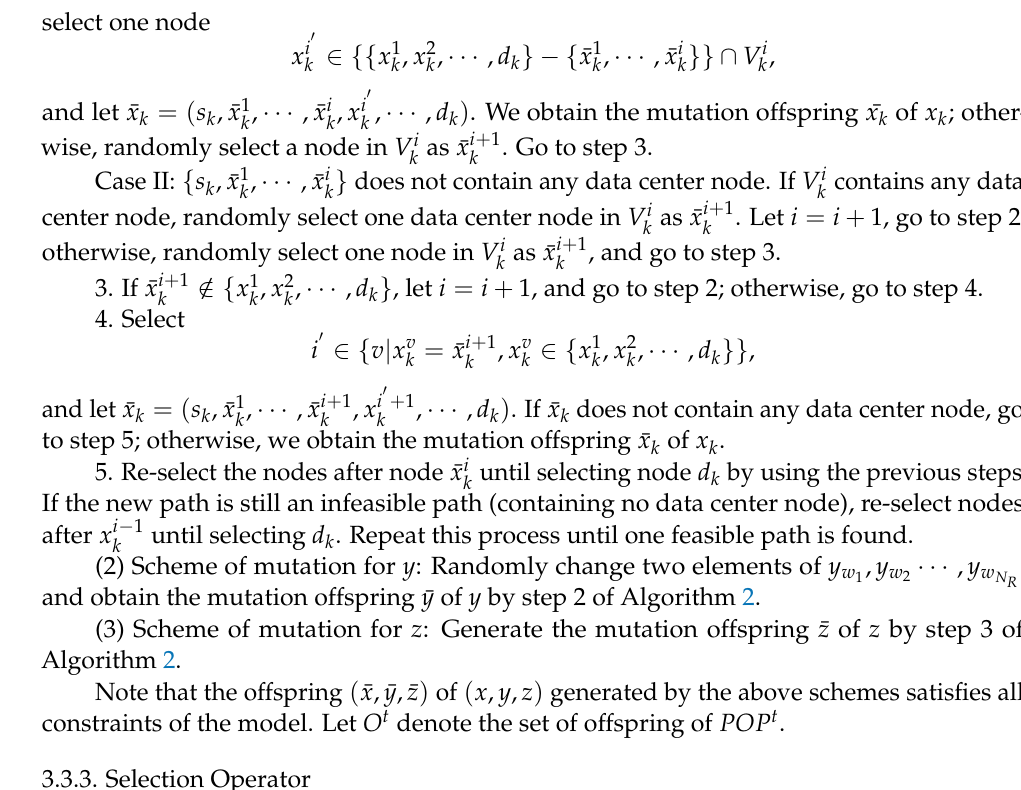
Algorithm 3 An evolutionary algorithm for the